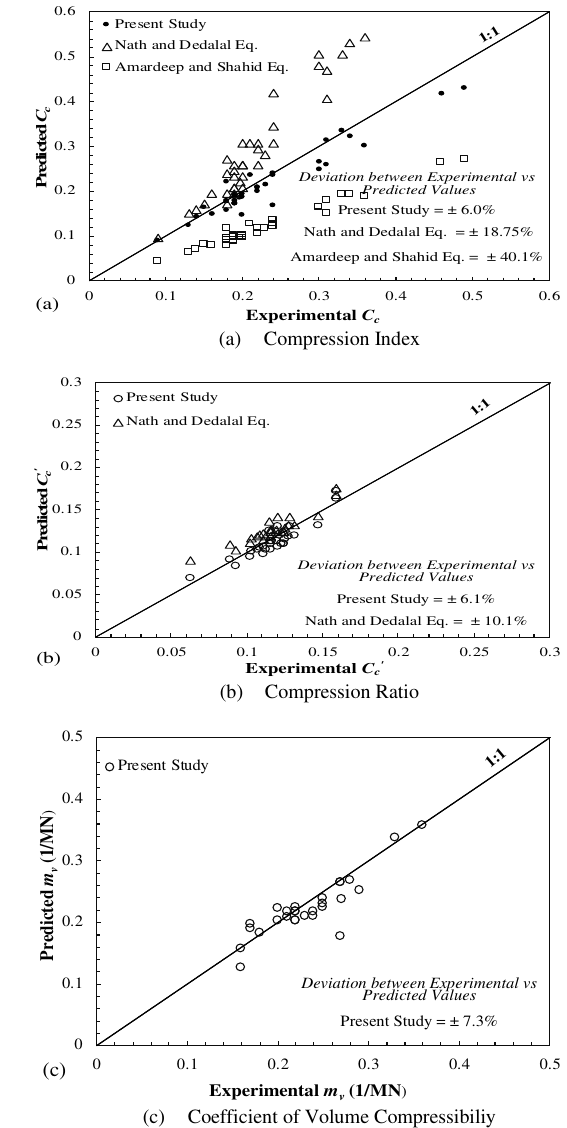
Fig. 6: Comparison between Experimental Vs Predicted Values of Compression Index based on Plasticity